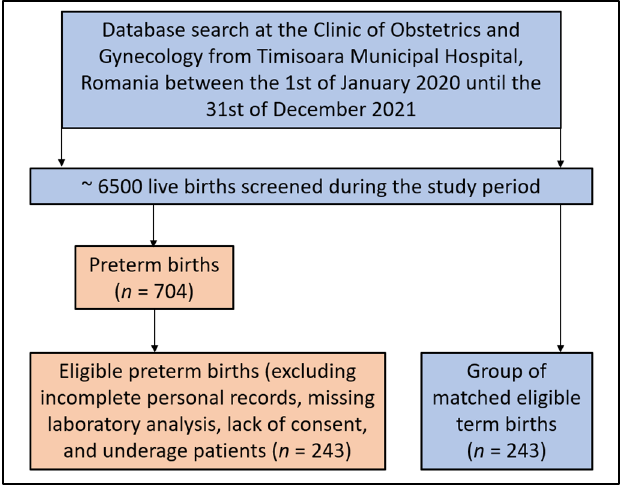
Figure 1. Flowchart of patients’ inclusion and exclusion criteria.